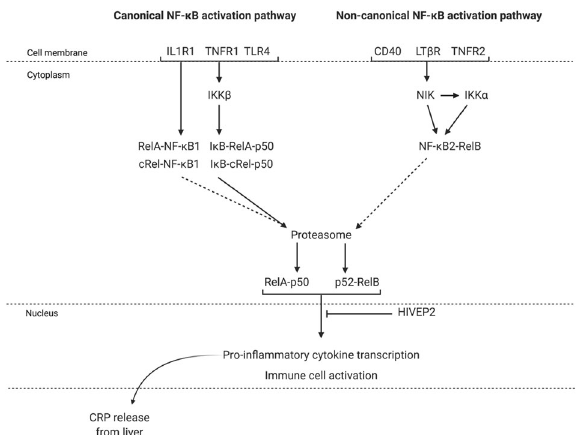
Fig. 1 NF- κ B activation . In canonical NF- κ B activation, immunor- eceptors such as interleukin-1 receptor type 1 (IL1R1),